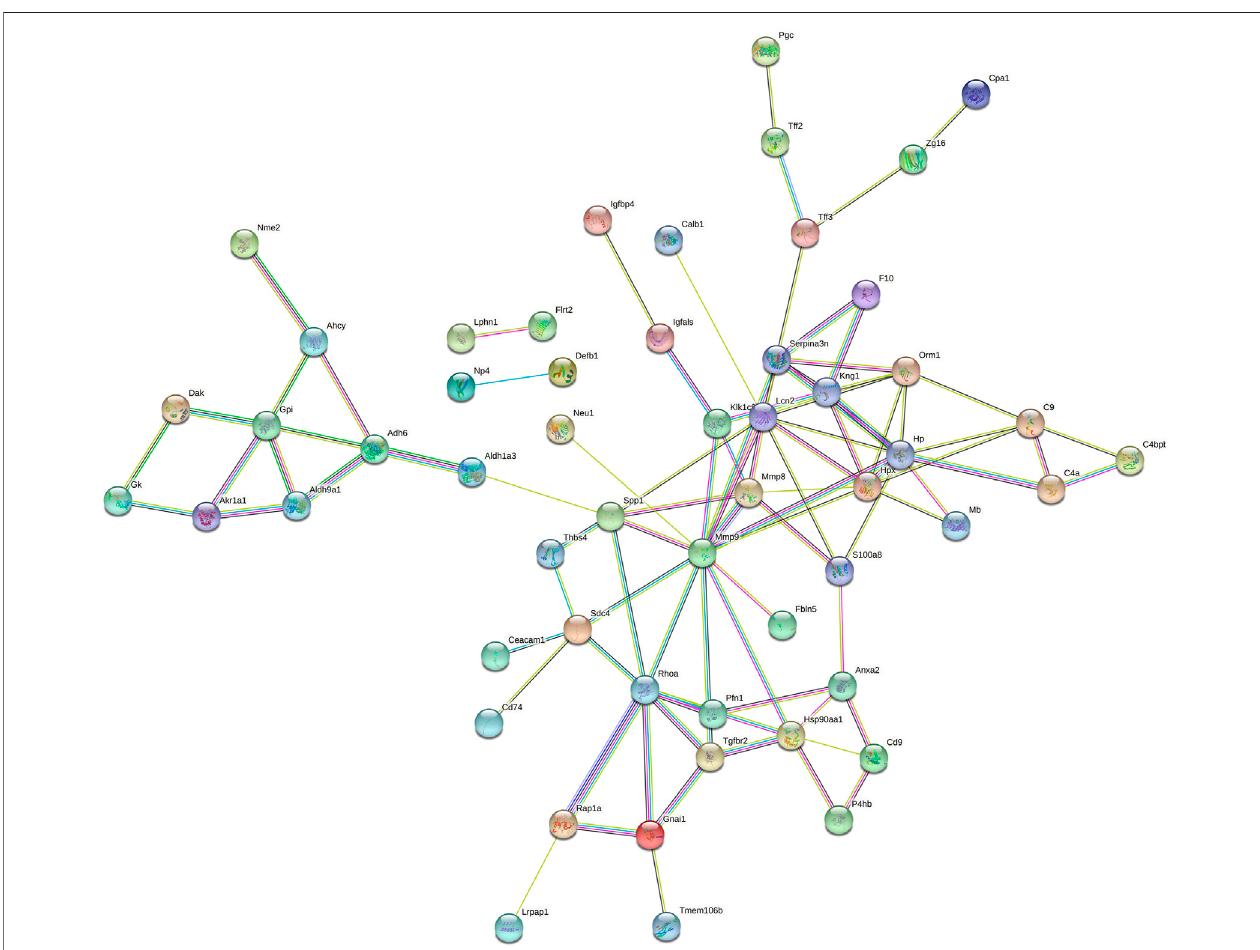
FIGURE 5 | STRING PPI network analysis of the 76 differential proteins in EAU rats. The average node degree is 2.56, average local clustering coef fi cient is 0.404, and PPI enrichment p -value is < 1.0e-16.